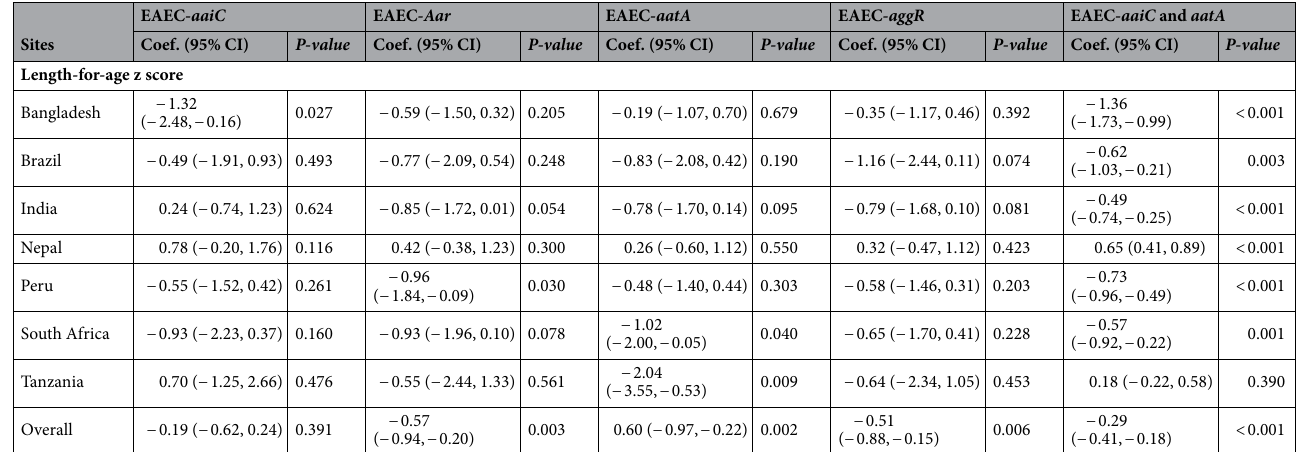
Table 4. Strain carrying genes of EAEC and burden on child growth at 24 months across each of the study sites (except Pakistan) from November 2009 to February 2012. Adjusted in the linear regression model for sex, birth weight, exclusive breastfeeding, WAMI Index (water/sanitation, assets, maternal education, and income); enrollment length-for-age z score; maternal BMI; poultry and cattle in house, a mother has less than 3 living children, average serum zinc level, average AGP (alpha-1-acid glycoprotein) level, presence of co-pathogens ( Campylobacter , LT-ETEC, ST-ETEC, Shigella /EIEC, and Giardia ) and site for overall estimate. Coef.: Coefficient; CI: Confidence interval. Dependent variable: length-for-age z score at 24 m; Independent variables: the burden of strain carrying genes associated with EAEC.